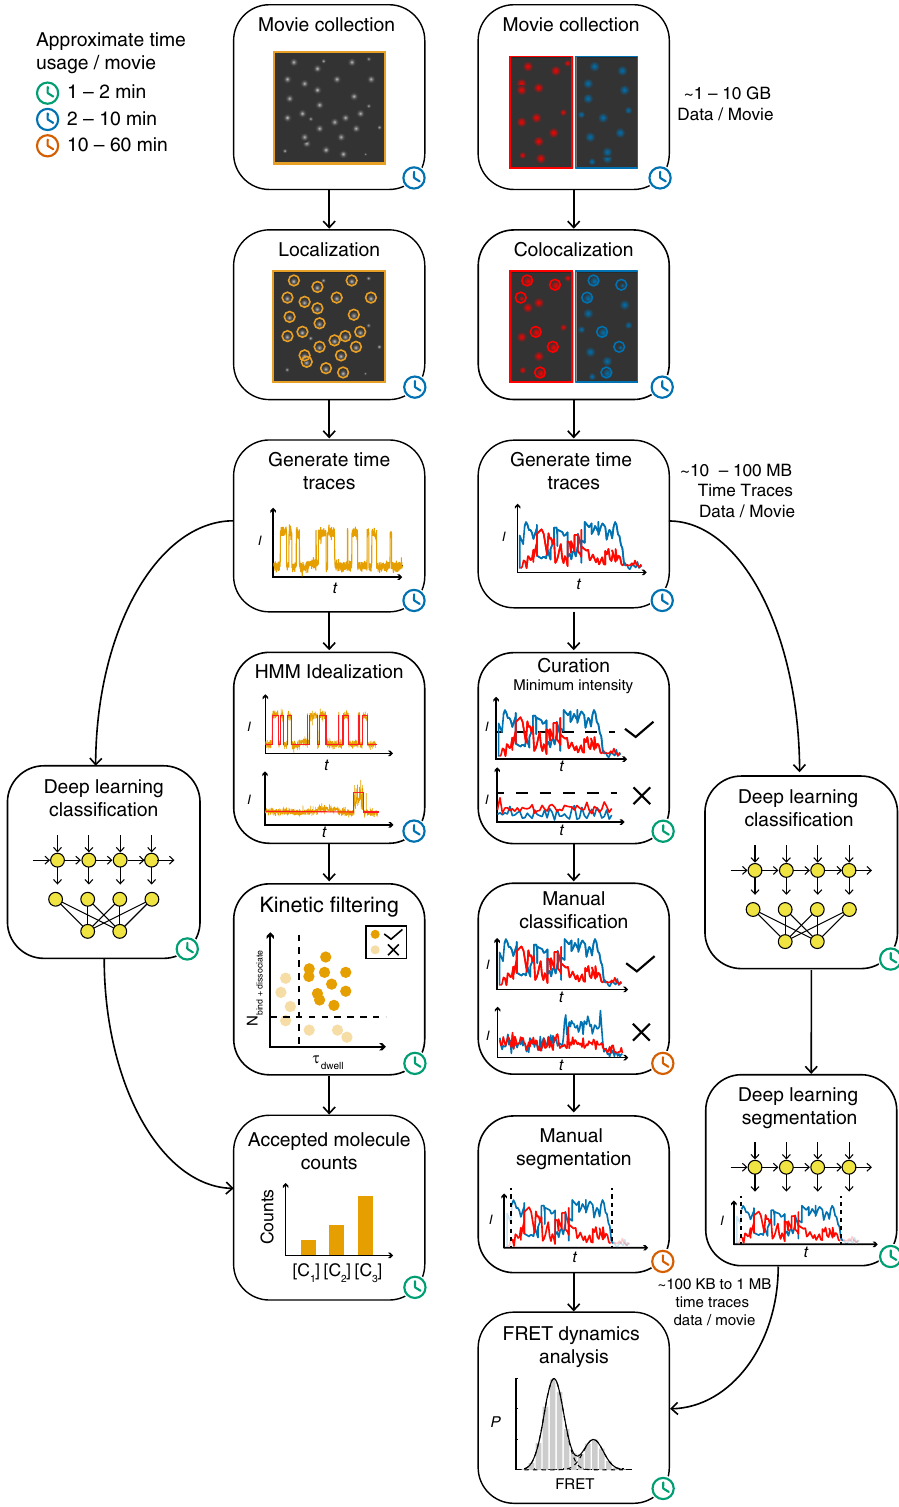
Fig. 1 Data analysis pipelines for single-channel SiMREPS (left) and two-channel smFRET (right) SMFM time traces as implemented in AutoSiM. The steps in each pipeline that are bypassed by the deep learning methods in this paper are shown. The approximate time required per movie for each step of analysis is indicated by a green, blue, or orange clock icon. In the chart, I = luorescence intensity, t = time, P = probability, N bind + dissociate = the number of observed binding and dissociation events per trace, and τ dwell = dwell